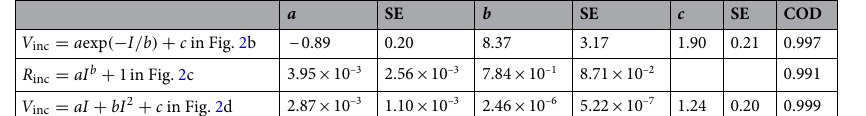
inc3 ) for 325 nm irradiation and fitted curve of inc for 808 nm irradiation and fitted curve of V = aI + bI 2 + c for the near- inc (cid:31)